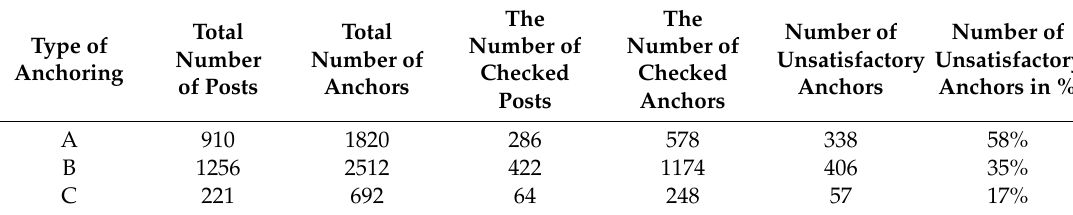
Table 1. Cumulative assessment for individual types of